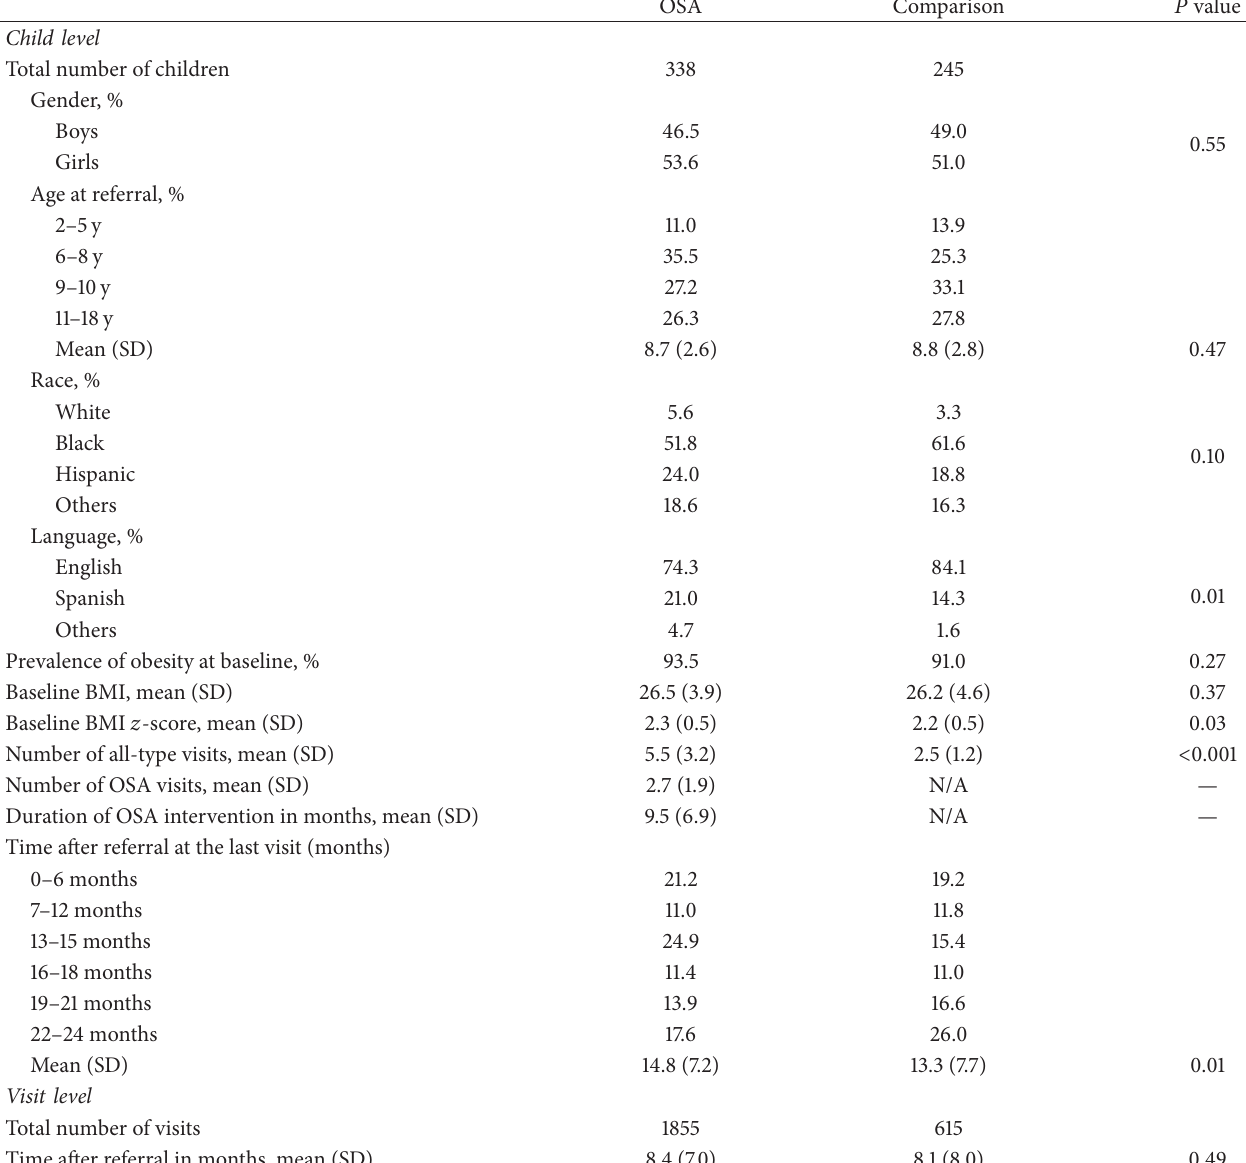
Table 1: Characteristics and visit frequency of analytic samples for the OSA and comparison groups.